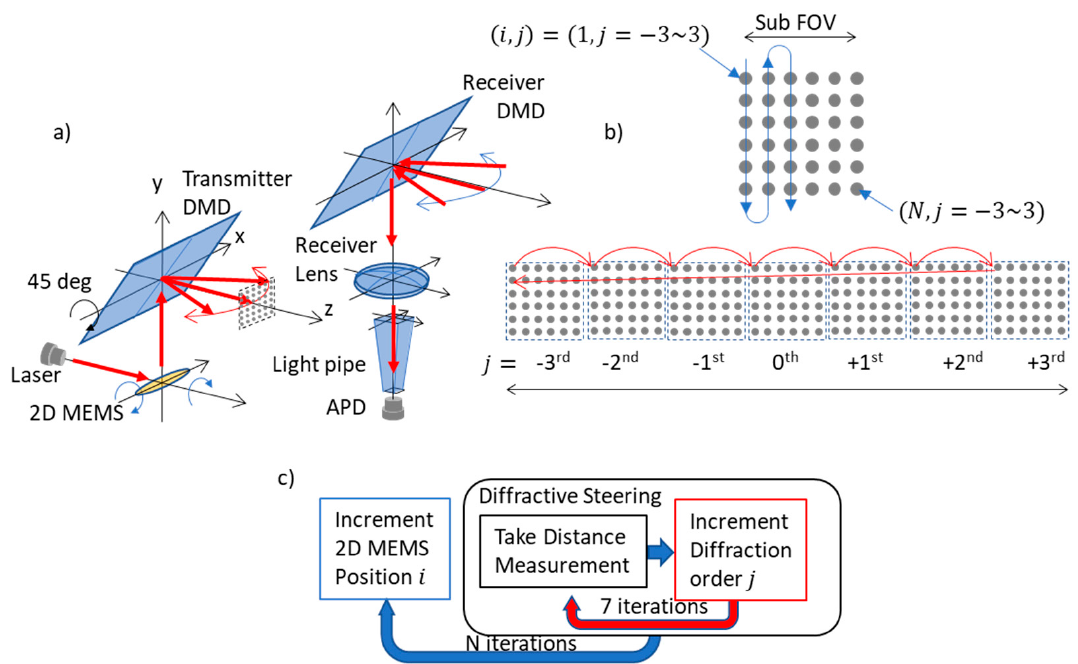
Figure 1. ( a ) Hybrid lidar optical architecture employing 2D-MEMS mirror, transmitter (Tx) DMD, and receiver (Rx) DMD. ( b ) 2D-MEMS mirror scan of the sub-FOV of N scanning points. ( c ) The DMD sequentially steers the scanning point within the sub-FOV into seven diffraction orders in an interleaved manner.